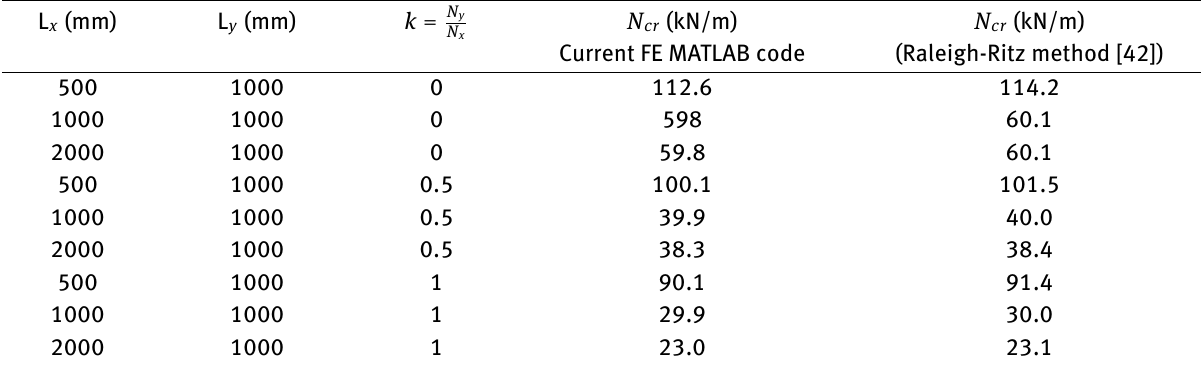
Table 1: Comparison of the critical buckling loads for a ([0 deg/90 deg] 2 / core] s sandwich plate. L x (mm)